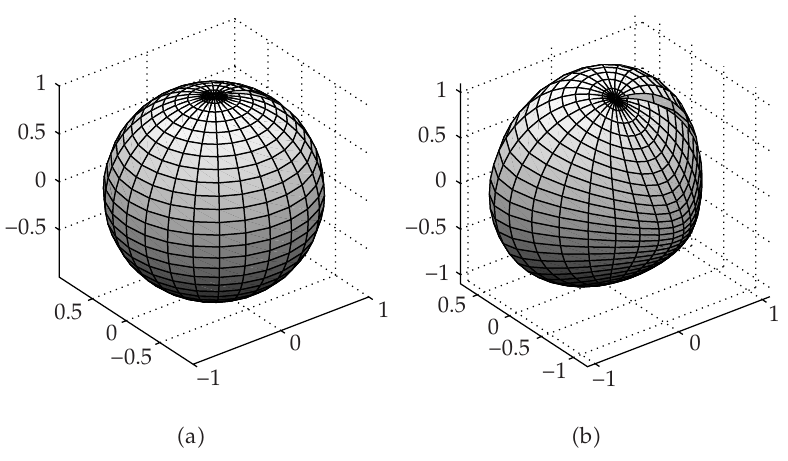
Figure 6.3 . The reference ( a ) and the deformed ( b ) configurations of the unit sphere Ω associated to the displacement function f .